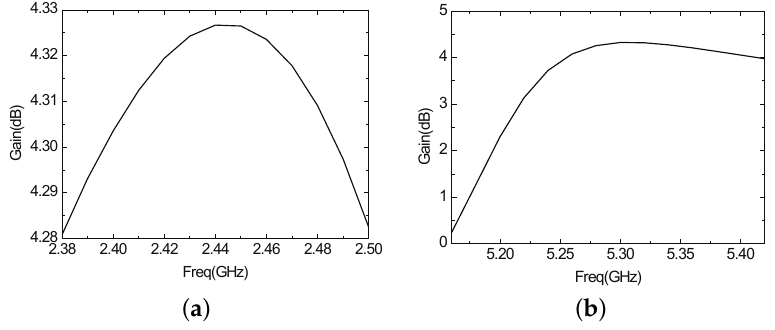
Figure 24. The gain of the improved antenna ( a ) 2.43 GHz; ( b ) 5.2